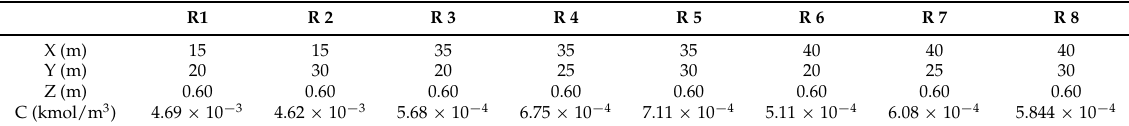
Table 16. The coordinates of the sensors and the corresponding concentration according to the standard rectangular deployment method.